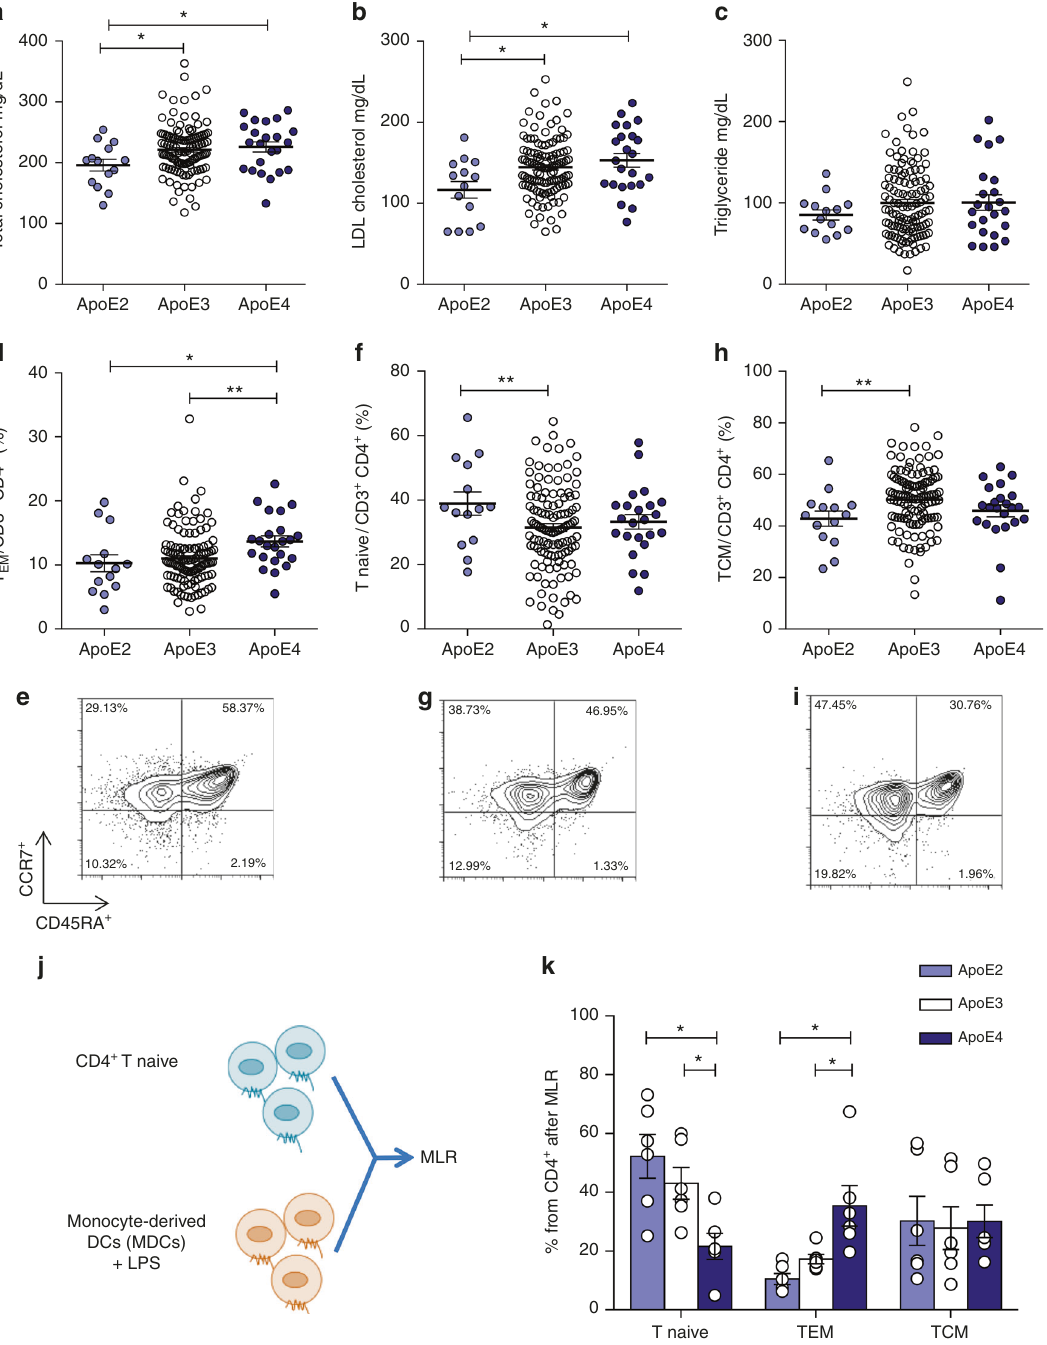
Fig. 6 Human carriers of apoE4 isoform present a more activated immune pro fi le as compared to carriers of the wild-type apoE3 isoform. a – c Plasma levels of total cholesterol ( a ), LDL-cholesterol ( b ) and triglycerides ( c ) from human carriers of apoE isoforms. d – i Percentage of circulating T EM (CD45RA- CCR7lo) ( d ), T naive (CD45RA + CCR7hi) ( f ) and T CM (CD45RA-CCR7hi) ( h ) CD4 + in carriers of the different apoE isoforms; representative dot plots are reported ( e , g , i ). j Graphic representation of mixed lymphocyte reaction (MLR) by CD4 + T naïve cells stimulated with monocyte-derived DCs (MDCs) pulsed with LPS (1 µ g/mL for 2 days) from human carriers of apoE isoforms. k Polarization of CD4 + T cells after MLR between mature MDCs and syngenic T naive cells. N = 6 per group ( k ). Statistical analysis was performed with two-way Anova. Data are reported as mean ± SEM; * p < 0.05, ** p <